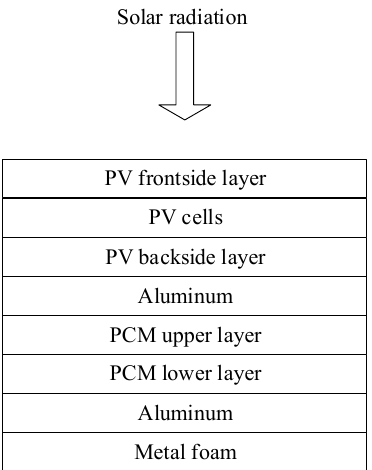
Figure 1. Schematic view of the PV/PCM-metal foam system.